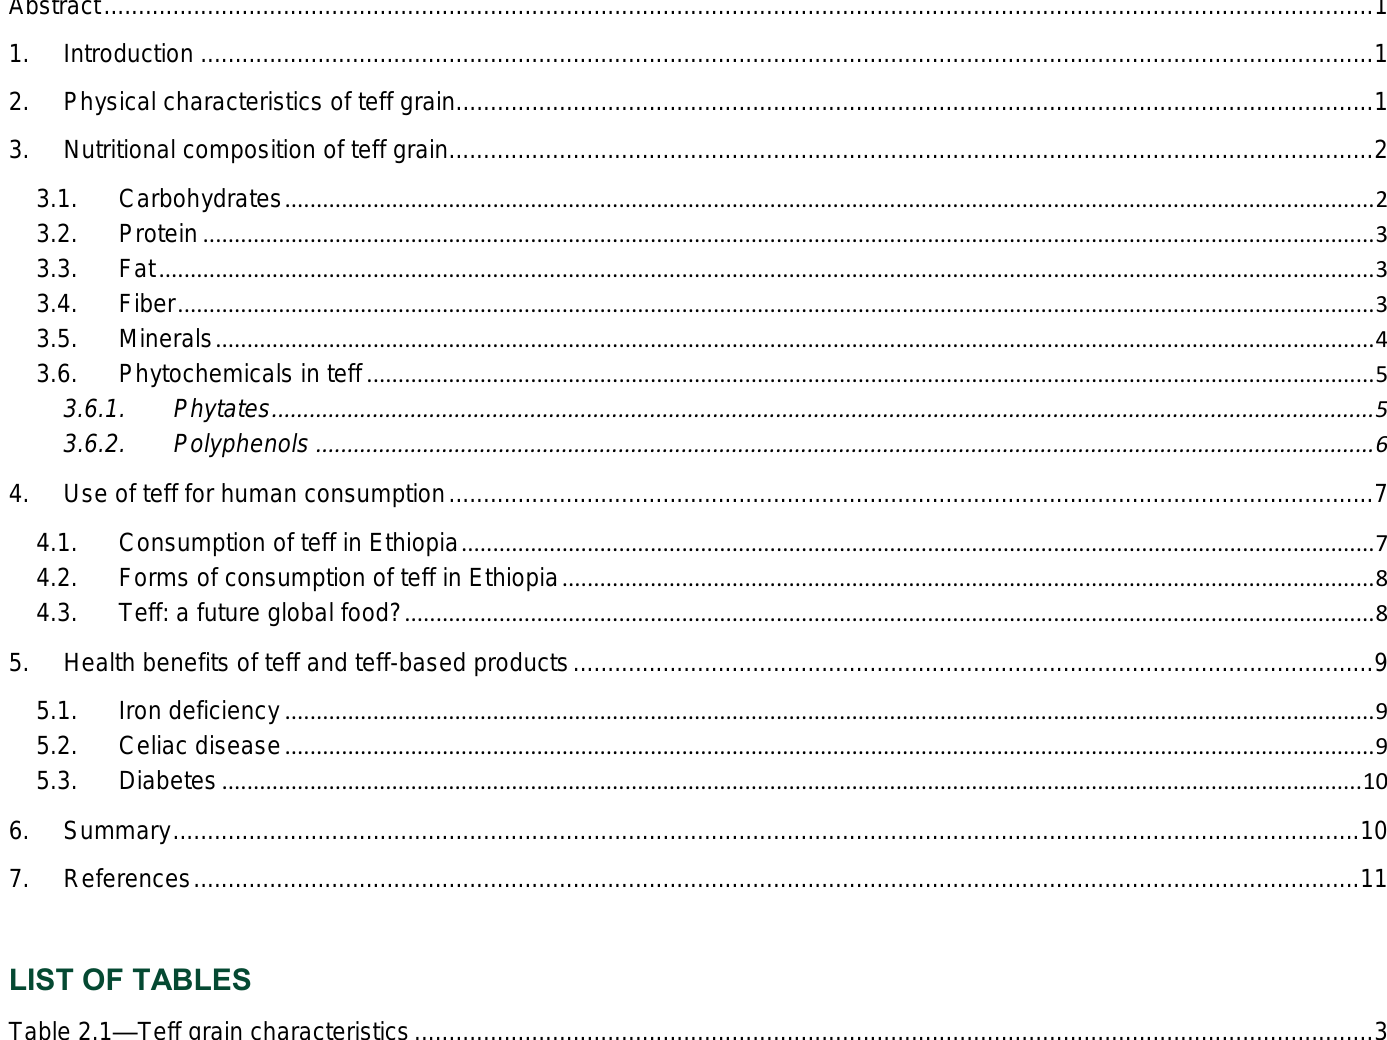
Figure 4.1 — Contribution to energy intake (calories) per capita of different cereals in Ethiopia .................................................